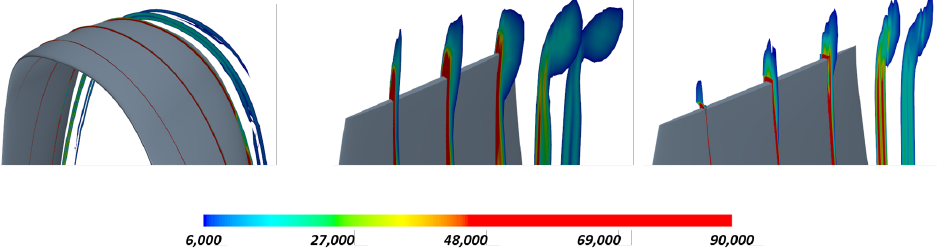
Figure 13. Contours of the transient vorticity magnitudes in the cutting planes arranged along the propeller axial direction. From left to right: Boxprop, Conprop-3 and